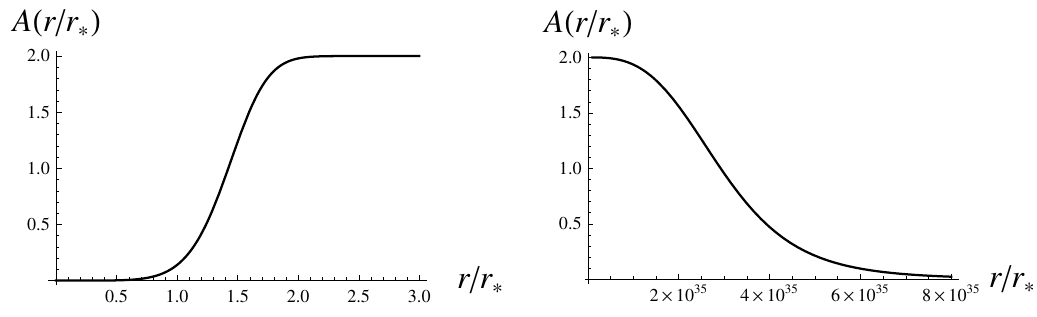
Figure 5. Behavior of the anisotropy parameter at the early stage and at the stage close to the present epoch. The anisotropy parameter grows quickly at the postinflationary stage. At the maximum of p ⊥ and b ( τ + r ) , it takes the value A (cid:39) 0.4, grows further achieving A = 2 at r (cid:39) 2.5 × 10 − 7